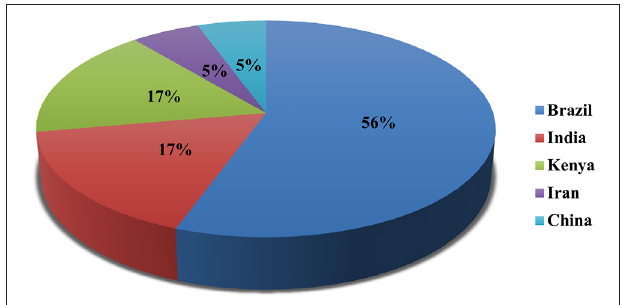
FIGURE 2 | Country-wise studies of nanoparticles against H. contortus . FIGURE 3 | Year-wise studies of nanoparticles against H. contortus .